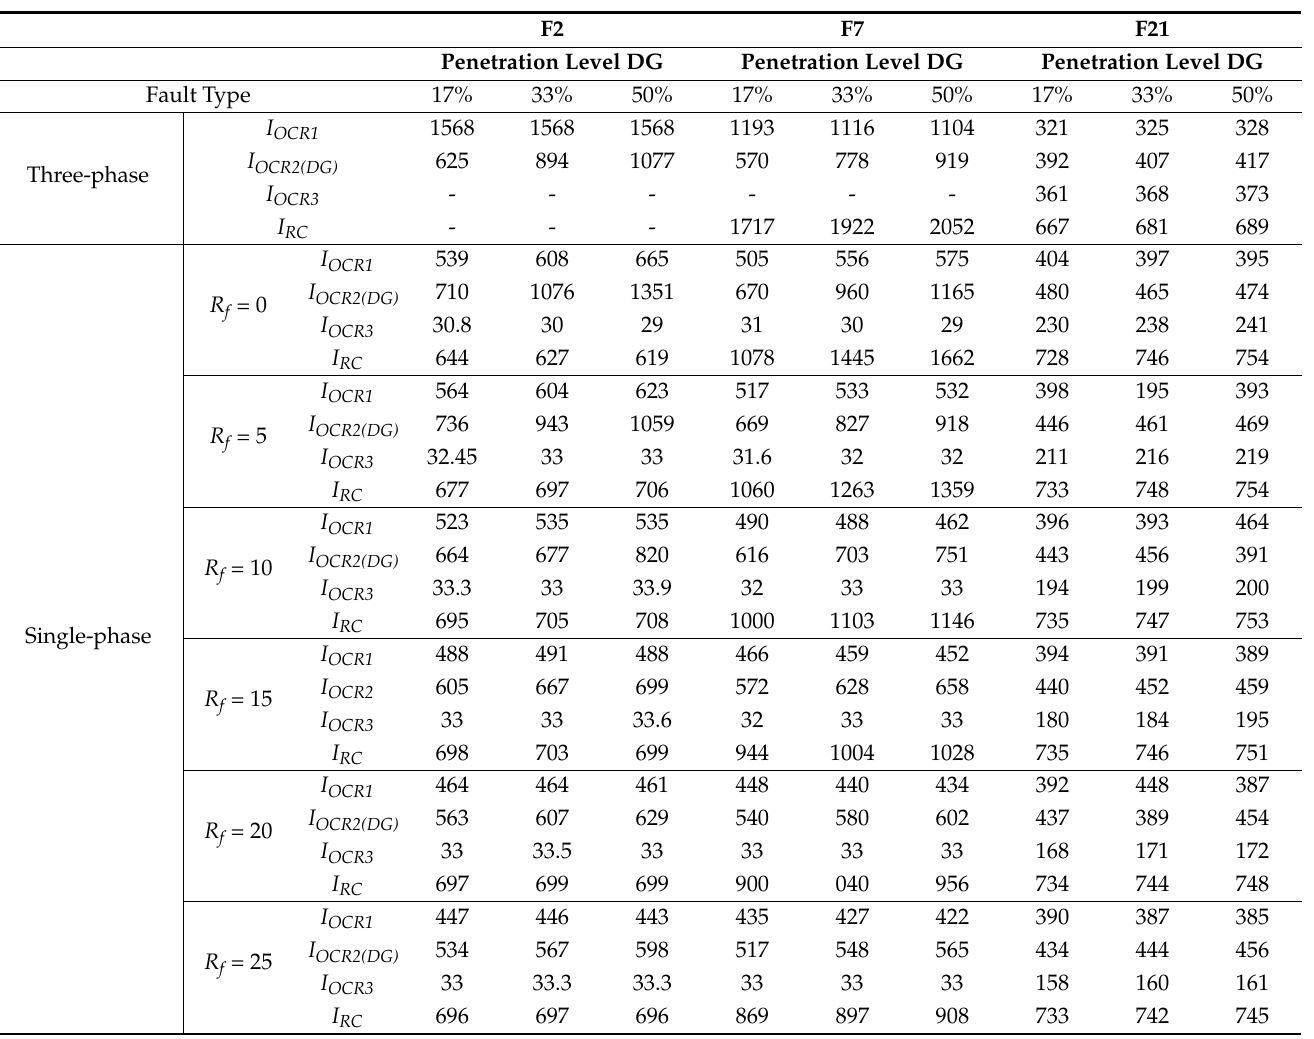
Table 3. Short circuit (expressed in amperes, A) detected by the protection devices, for different grounding resistor values, R f , expressed in